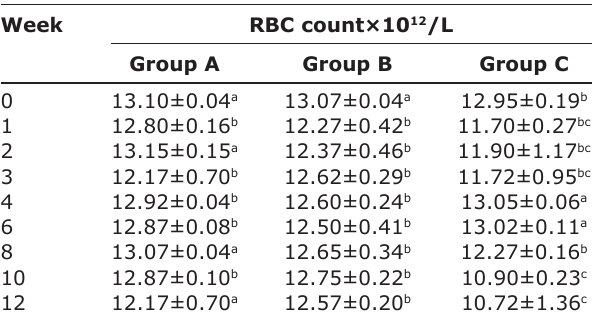
Table-3: PCV in female goat’s postinoculation with C. pseudotuberculosis and MA.